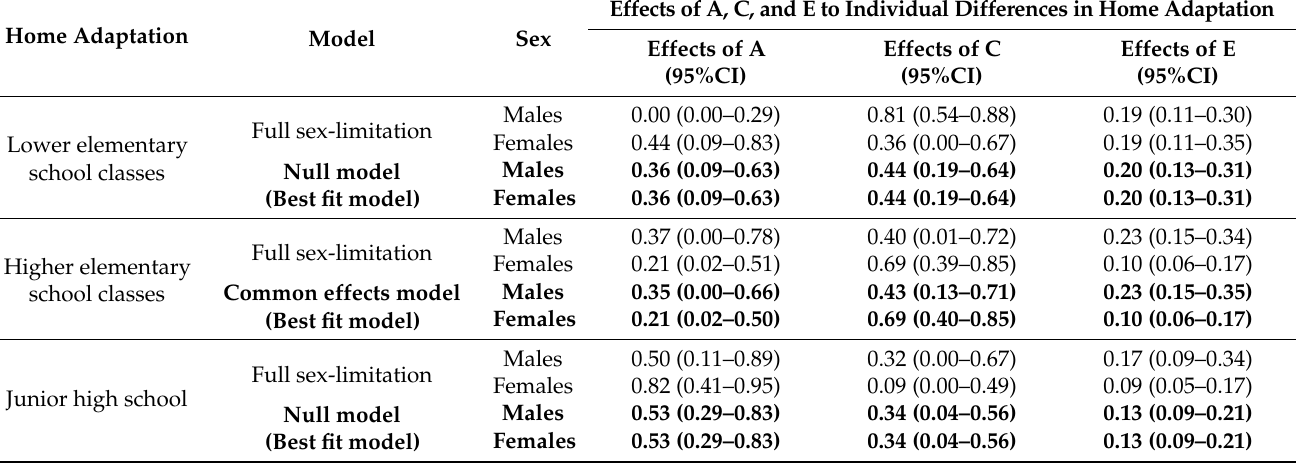
Table 9. Parameter estimates of home adaptation from sex-limitation model